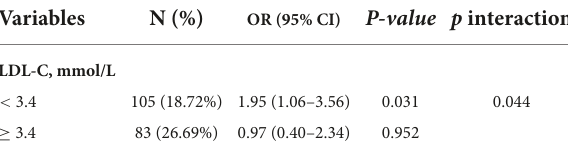
TABLE 4 Association of remnant lipoprotein cholesterol (RC) for new-onset carotid plaque modified by baseline low-density lipoprotein cholesterol (LDL-C)